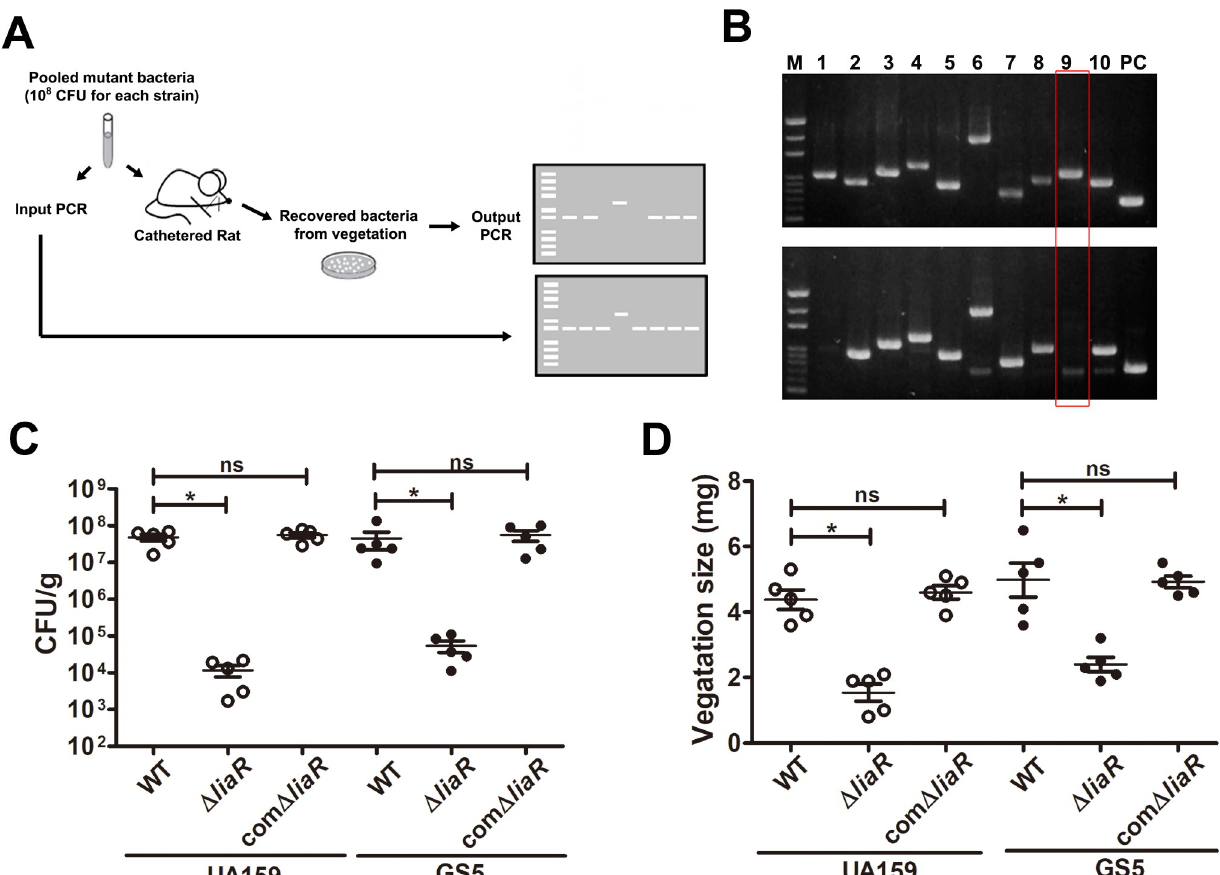
Fig 1. LiaR -deficient mutant strain shows reduce ability to cause vegetation formation in experimental rat IE model. (A) Schematic diagram of in vivo survival assay. A mix of 10 insertion mutants of transcription regulators was injected (10 8 for each) into catharized rats, and the bacteria colonized inside the vegetation on damaged valves were identified by specific primers. (B) The upper panel is a representative PCR result of injected bacterial mixtures (input PCR); the bottom panel is a representative PCR result of bacteria colonized inside the vegetation. M, DNA marker; lane 1, the PCR result using the primers for detecting SMU . 1146 -deficient mutant; lane 2, SMU . 927 ; lane 3, SMU . 1815 ; lane 4, SMU . 659 ; lane 5, SMU . 1038 ; lane 6, SMU . 1008 ; lane 7, SMU . 1964 ; lane 8, SMU . 576 ; lane 9, SMU . 487 (LiaR); lane 10, SMU . 1547 ; and PC, positive control, PCR product of 16S rRNA gene. (C and D) The role of LiaR in the pathogenesis of S . mutans -induced IE was investigated using Δ liaR and com Δ liaR strains of GS5 and UA159 in experimental rat endocarditis models. The number of colonized bacteria inside vegetations (C) and vegetation size (D) were measured. Data represent the means ± standard error of the means and were statistically analyzed using the Kruskal-Wallis test with subsequent Dunn’s test; � P < 0.05, ns, not significant. IE, infective endocarditis; PCR, polymerase chain reaction; and CLSM, confocal laser scanning microscopy.